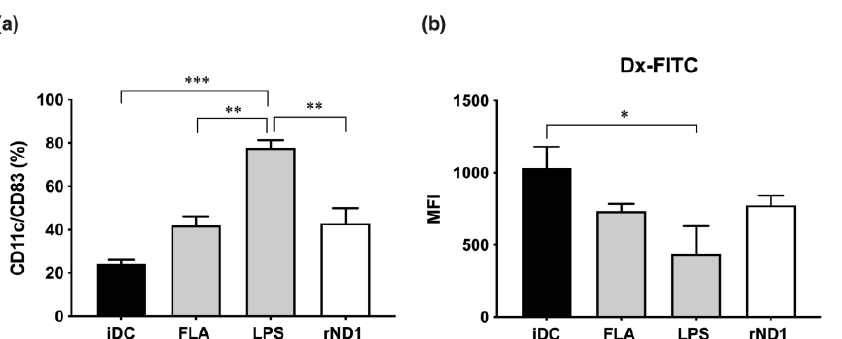
Figure 4. Monocyte-derived dendritic cells are insensitive to rND1 stimulation. ( a ) Percentage of expression of CD83 in CD11c + DC in iDC, and FLA, LPS, and rND1 treated cells for 18 h. The values represent the means of three independent experiments; ( b ) Median fluorescent intensity associated with the uptake of FITC-dextran by iDC, treated with FLA, LPS, and rND1 for 18 h, respectively. One-way ANOVA and Tukey’s multiple comparison tests. iDC: immadure dendritic cell; mDC: mature dendritic cell. FLA: Flagellin from S. typhimurium (100 ng/mL); LPS: Lipopolysaccharide from E. coli K12 strain (1 µ g/mL); rND1: recombinant amino terminus D1 domain from V. anguillarum flagellin (5 μ g/mL). * p < 0.05; ** p < 0.01, and *** p < 0.001.